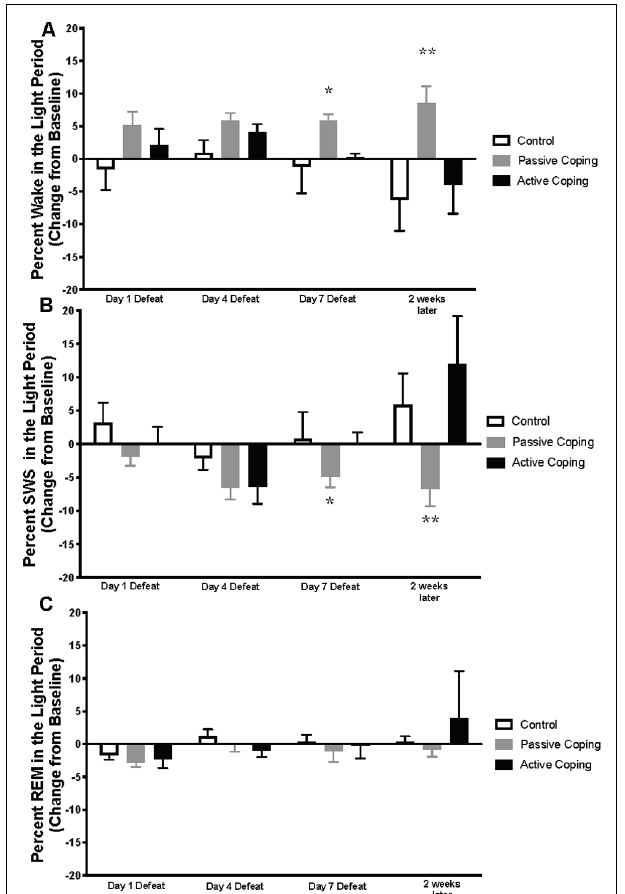
FIGURE 2 | Percent wake, SWS, and REM in the light period presented as change from baseline on Day 1, 4, and 7 of Defeat, and 2 weeks later. (A) Percent time spent awake during the light period in control ( n = 7), passively ( n = 15), and actively ( n = 8) coping rats. Passively coping rats spend more time awake than control and actively coping rats after 7 days of defeat and this persists 2 weeks after defeat. (B) Percent time spent in slow-wave sleep (SWS) during the light period in control ( n = 7), passively ( n = 15), and actively ( n = 8) coping rats. Passively coping rats displayed significantly less time in SWS compared to the other two groups after 7 days of defeat, and this persisted 2 weeks after defeat. (C) Percent time spent in REM sleep during the light period in control ( n = 7), passively ( n = 15), and actively ( n = 8) coping rats. No significant differences in REM sleep were detected between groups at any time point during the light period. * P < 0.05, ** P <